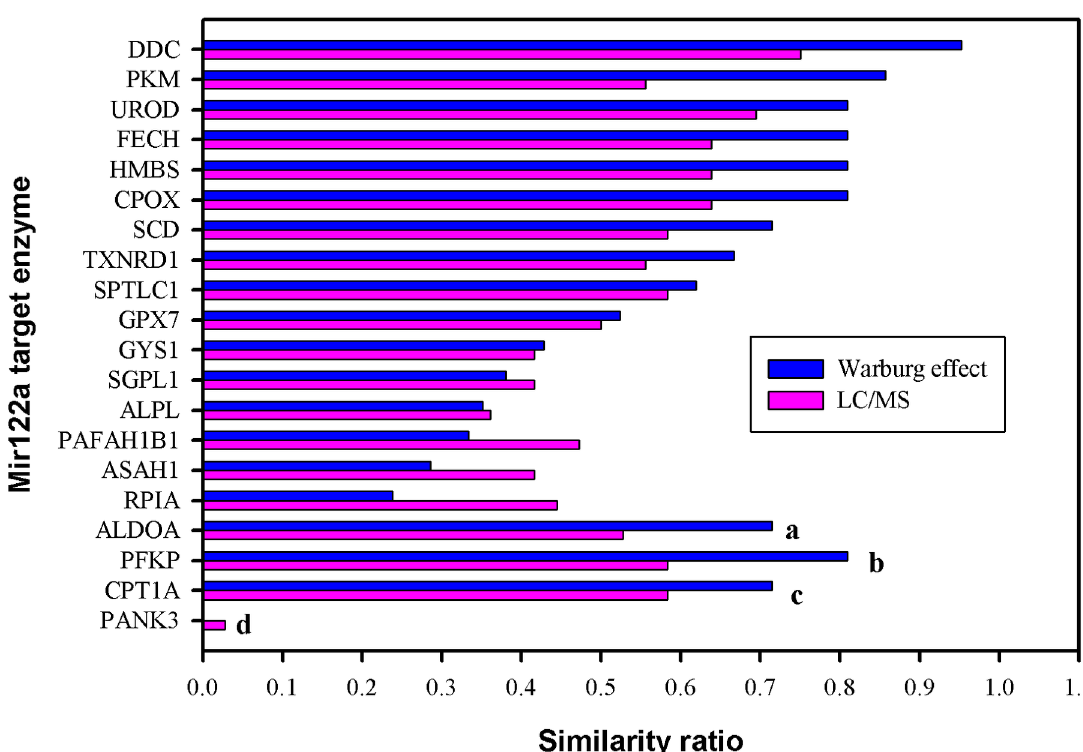
Fig 2. Similarity ratio of 20 miR-122atarget enzymesto Warburg effect and experimental metabolic profiling observations (LC/MS). The similarity ratio of each target gene was calculatedto indicate that how many percentages for the computational predictions(100% overexpression) are similar to the hypothesisof the Warburg effect (blue line) and experimental metabolicprofilingobservations(pink line). The Ddc gene receivedthe highestsimilarity ratio to the Warburg effect (0.952) and experiments (0.75) (a, 54% overexpression; b, downregulation; c, knockout; d, overexpression of forward and reverse reactions).